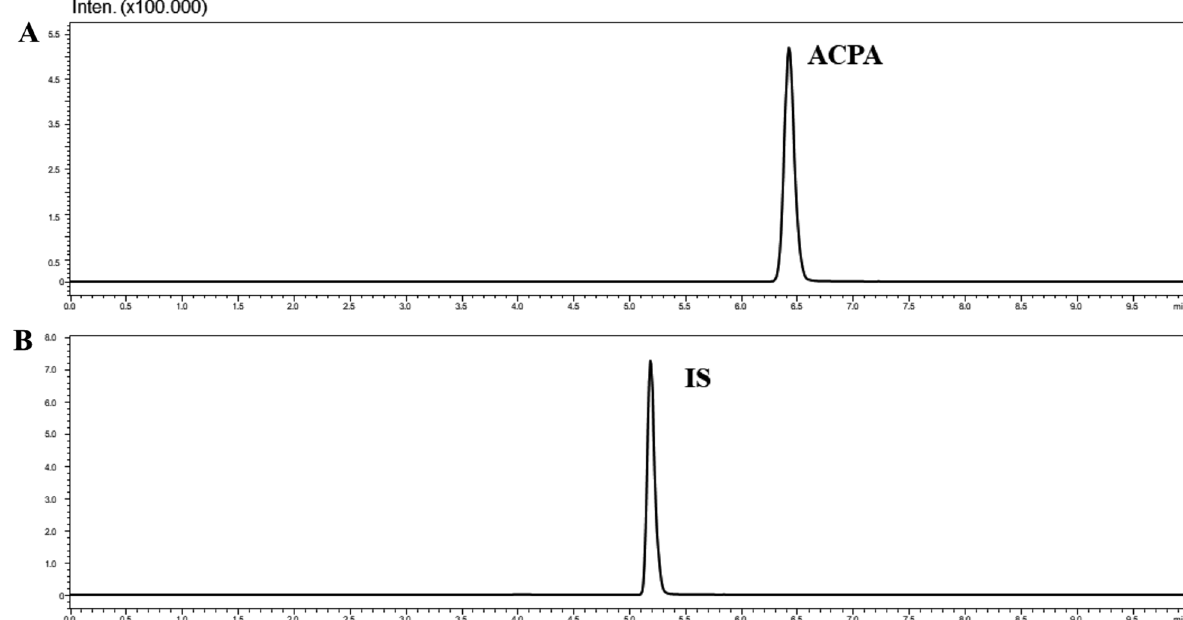
Fig. 2 Representative chromatograms of A ACPA (1000 ng/mL) and B IS (1000 ng/mL) at optimum chromatographic